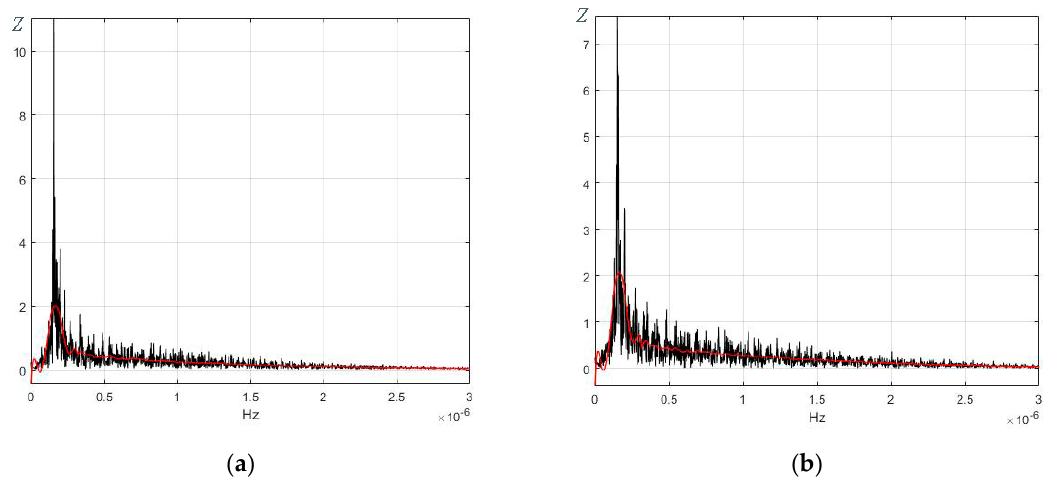
Figure 9. Fourier series plots for Z(t). Black line: Fourier series; red lines: Savitzky-Golay filter; ( a ) idle transmission; and ( b ) transmission with useful signal.